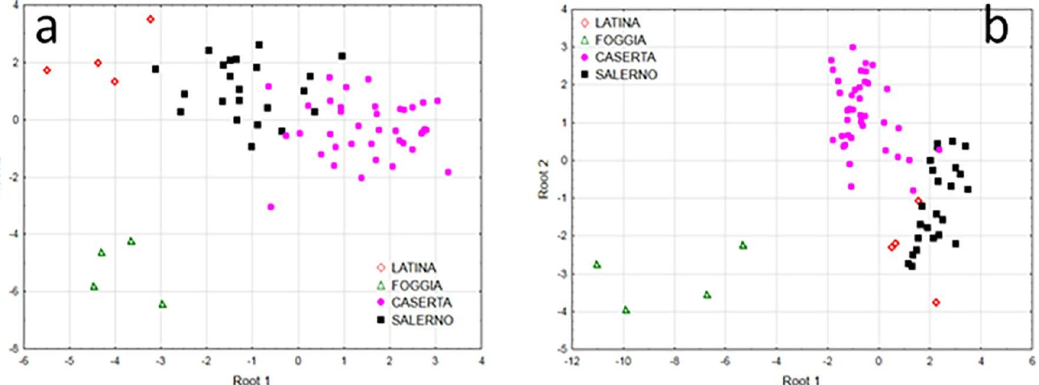
Figure 8. Score plots of canonical discriminant analysis of the isotopic and elemental composition of milk and Mozzarella di Bufala Campana PDO from Caserta, Salerno, Latina and Foggia, for milk ( a ) and mozzarella ( b ) (Source: [35]).